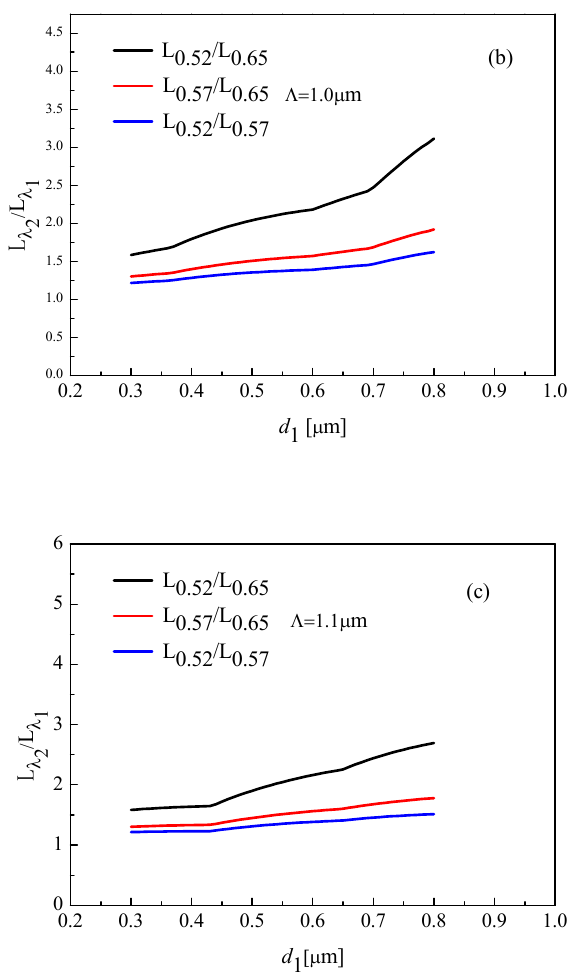
Figure 5. d 1 dependence of the different coupling ratios, ( a ) when d/ Λ = 0.9, ( b ) when d/ Λ = 1.0, and ( c ) when d/ Λ = 1.1.